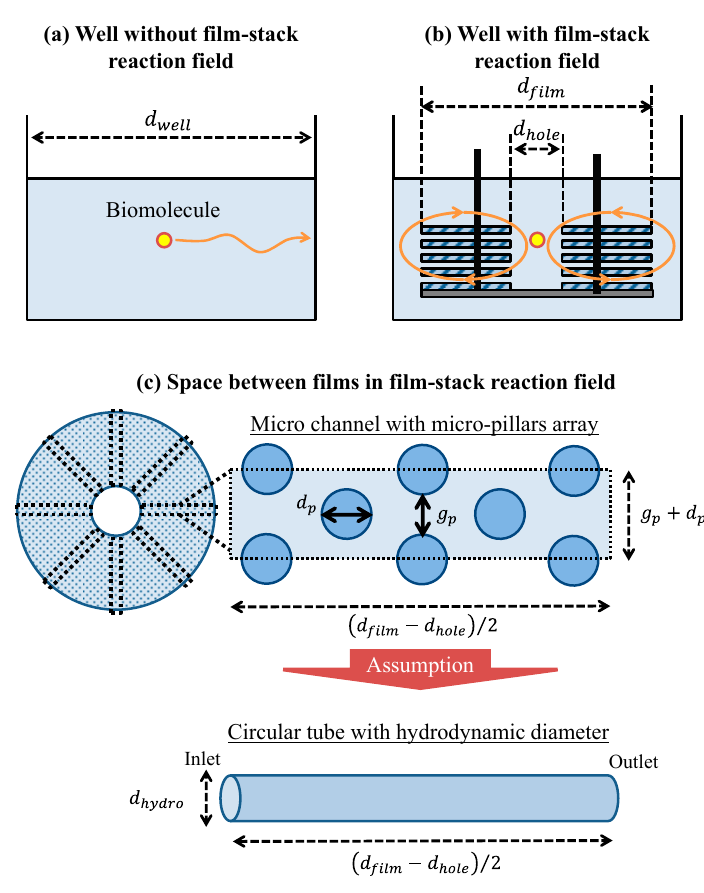
Figure 5. Geometric models of the well ( a ) with and ( b ) without the film-stack reaction field including the transport of one biomolecule. ( c ) Conceptual model of the fluid flow and biomolecule transport through the space between films. d well , d film , and d hole are the well diameter, the outside diameter of a film, and the central-hole diameter of a film, respectively. g p and d p are the gap between the micropillars and the pillar diameter, respectively. d hydro is the hydrodynamic diameter of a circular tube.